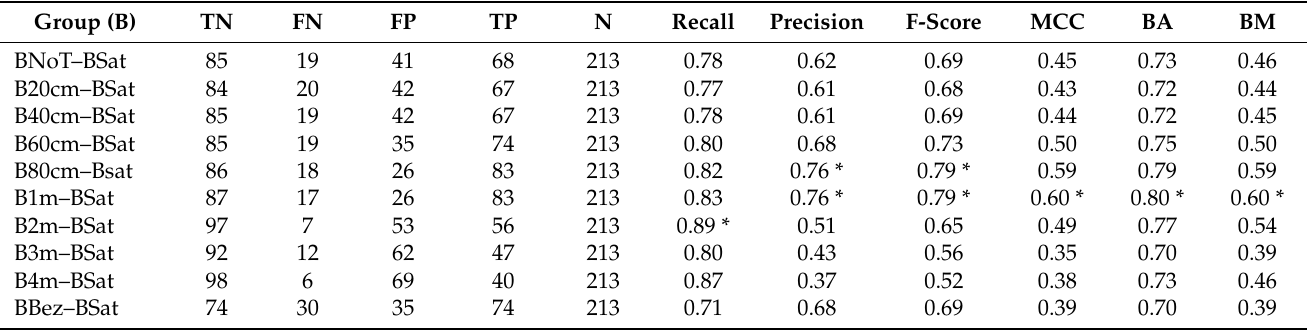
Table 4. The comparison of curve prediction accuracy rates for the forest road in terms of generalization tolerance values.